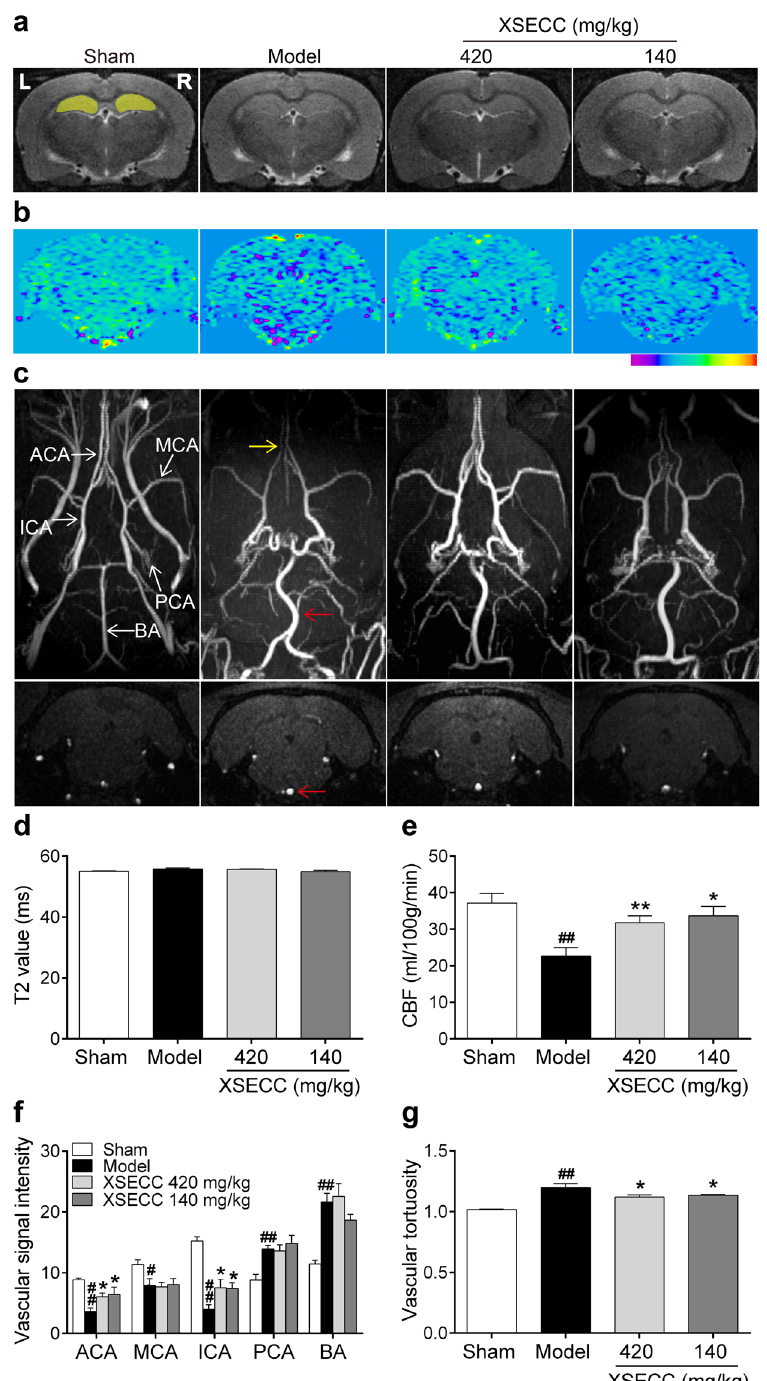
Figure 2. Effects of XSECC on cerebral vessels and cerebral blood flow in BCCAO rats. ( a ) Representative T2 relaxometry images of various group rats. The yellow cover on the sham group indicated ROIs of the bilateral hippocampus (R, right; L, left). ( b ) Typical CBF maps obtained from ASL at the hippocampus level ( − 3.8 mm relative to bregma). ( c ) Representative axial MIP maps (upper panel) and coronal data set images (lower panel) of MRA exhibited relatively distinguished cerebral vessels. ACA, MCA, ICA, PCA and BA were identified in the sham group map (ACA, anterior cerebral artery; MCA, middle cerebral artery; ICA, internal carotid artery; PCA, posterior cerebral artery; BA, basilar artery). The red arrow presented the signal-enhanced and tortuous BA, and the yellow arrow presented the weaken signal of ACA. Quantitation of hippocampal T2 values ( d ), hippocampal CBF ( e ), and vascular intensity of ACA, MCA, ICA, PCA, BA ( f ) and vascular tortuosity of BA ( g ). # P < 0.05, ## P < 0.01 vs . sham group; * P < 0.05, ** P < 0.01 vs . model group (one-way ANOVA followed by LSD’s post hoc test, n = 6 per